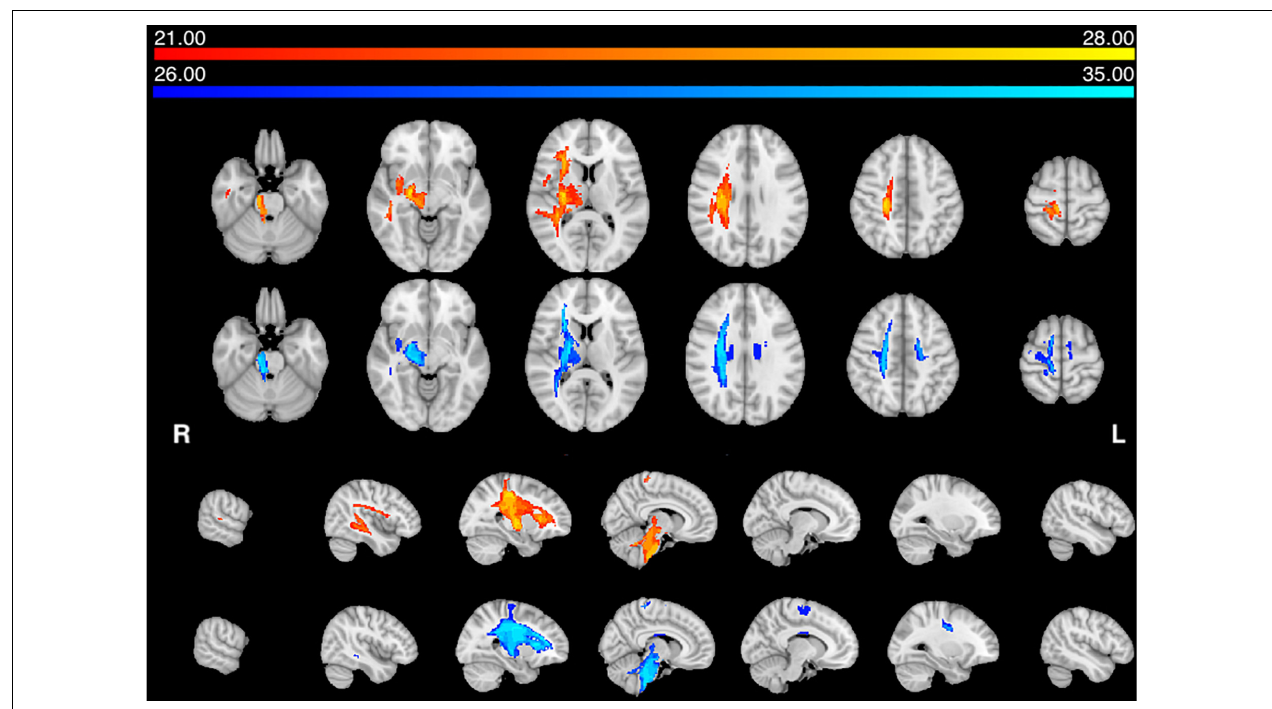
FIGURE 2 | Structural disconnection frequency map (75%): Voxels of white matter tract overlap in AHP (orange–yellow) and HP (blue-teal) groups. The color scale indicates max number of patients per